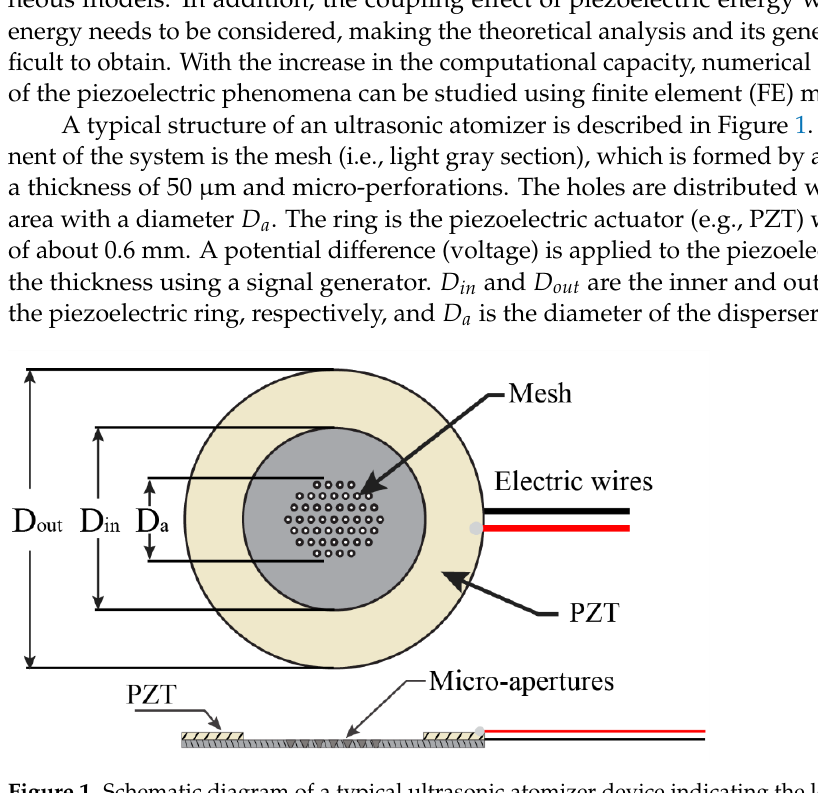
Figure 1. Schematic diagram of a typical ultrasonic atomizer device indicating the location mesh and its micro-aperture